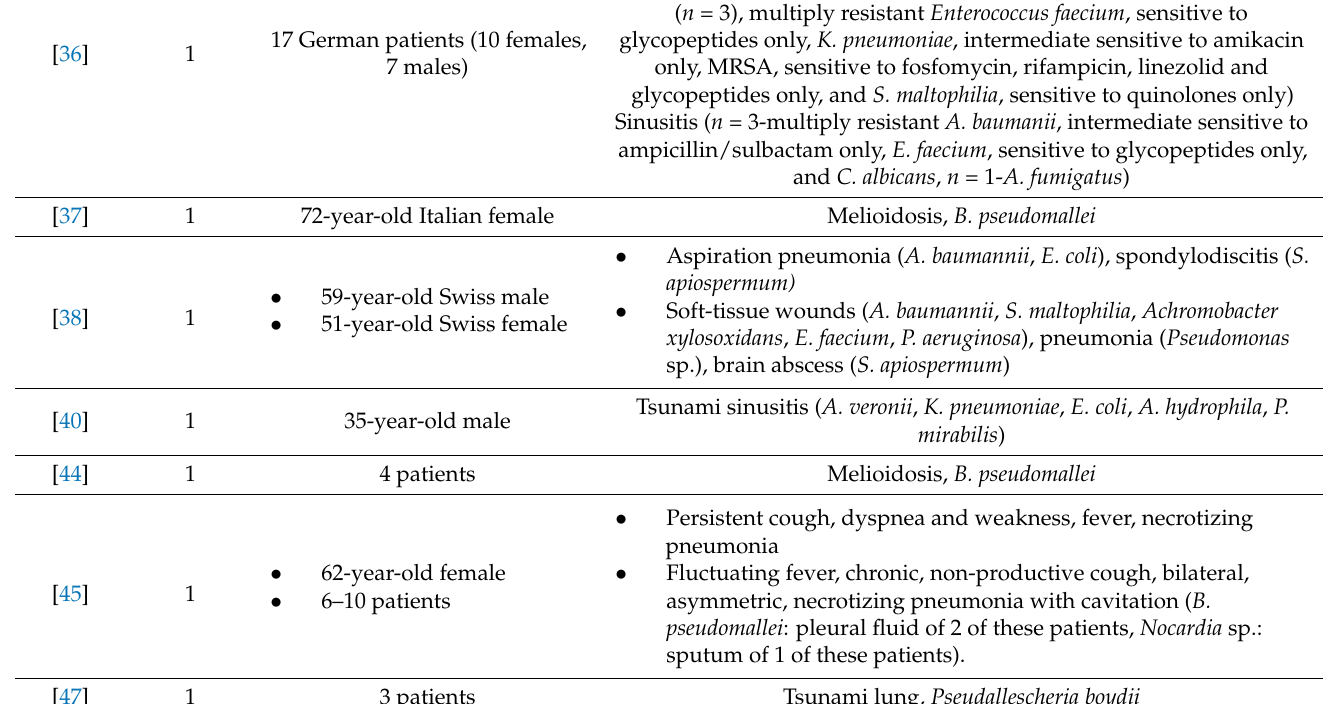
pseudomallei : pleural fluid of 2 of these patients, Nocardia sp.: sputum of 1 of these